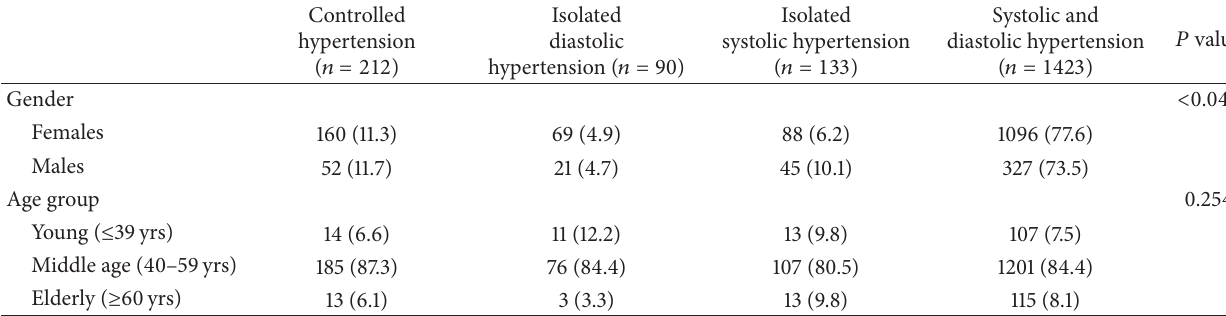
Table 2: Age group and gender relations of hypertension subtypes.